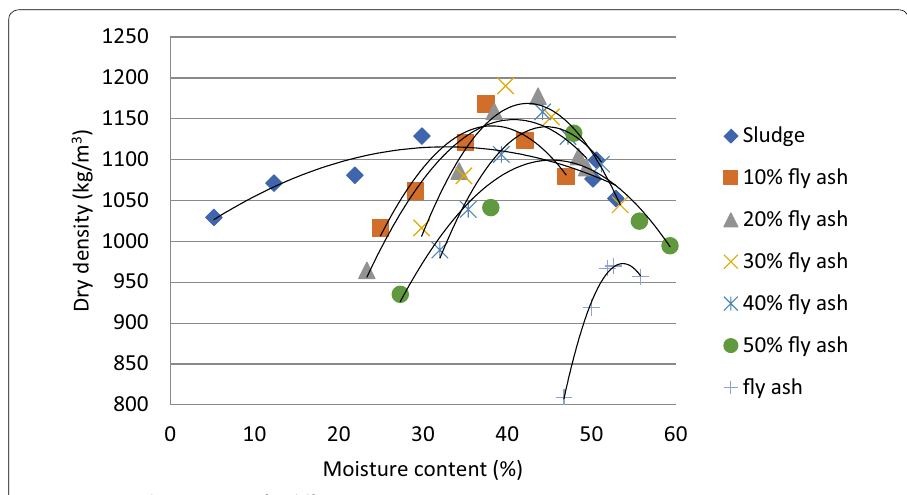
Fig. 3 Proctor density curves for different mix proportions